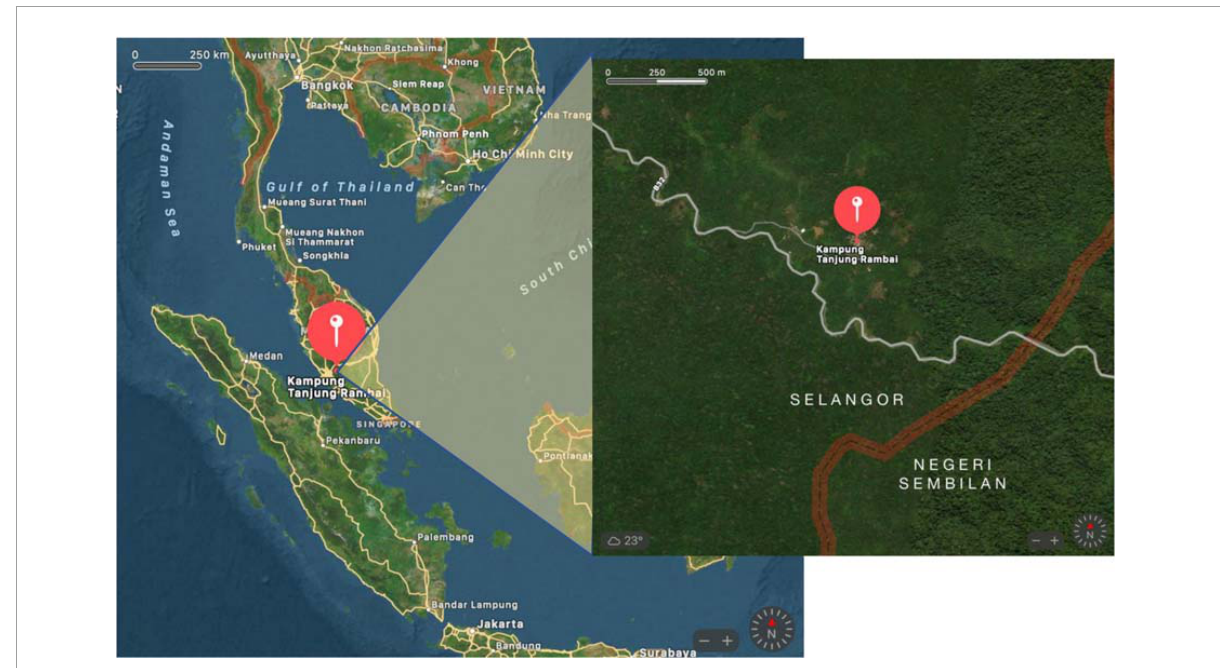
FIGURE1 Location of Kampung Tanjung Rambai. Source: Apple Maps accessed at 21.42 (GMT + 7) on 14 October